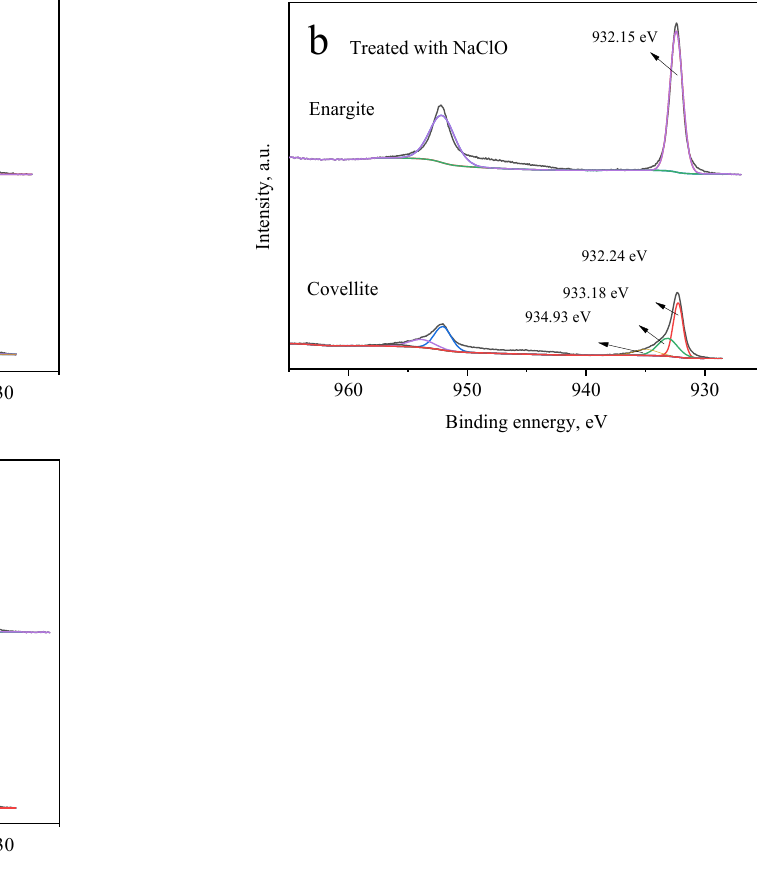
Figure 7. Cu 2p3/2 spectra of the covellite and enargite samples treated with different depressants: ( a ) fresh samples, ( b ) NaClO, and ( c ) NaClO + FeCl 3 .